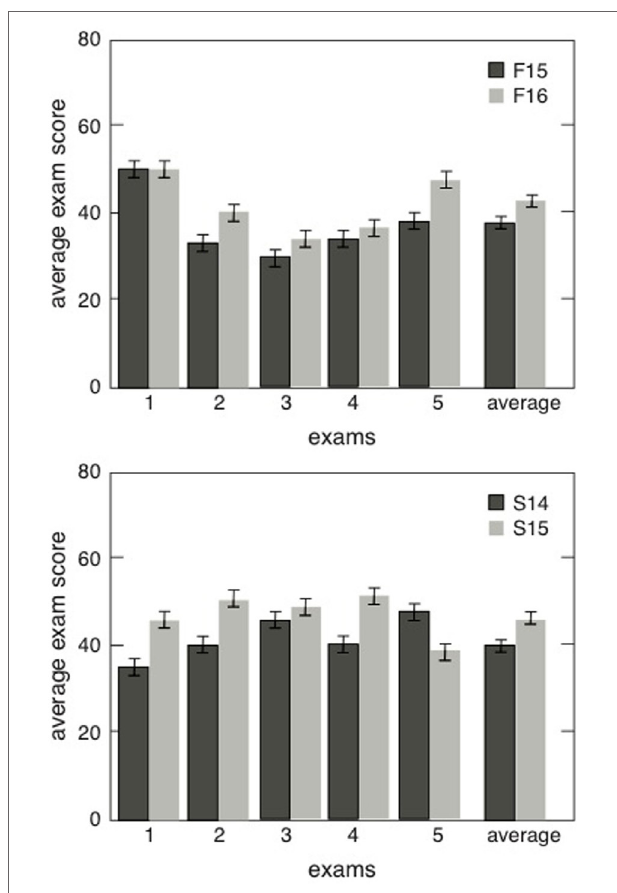
FigUre 14 | Exam performance comparison between two different cohorts of the same course where the only difference is the use of Perusall as the online learning platform. The error bars represent the